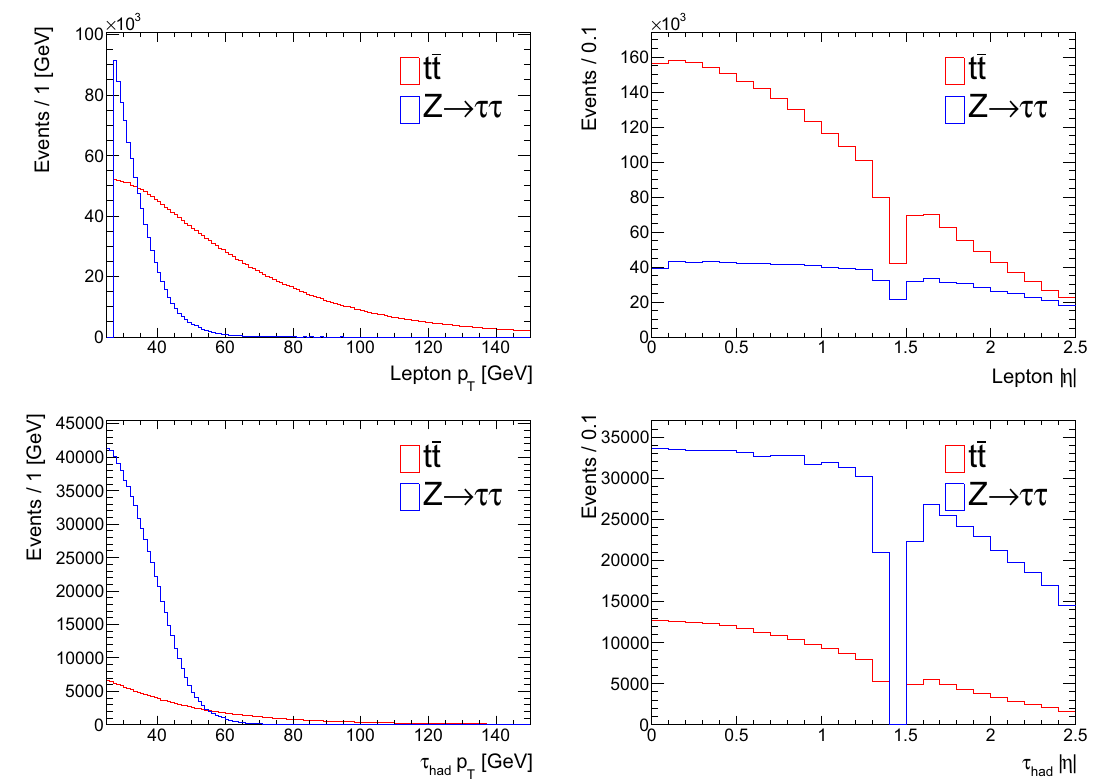
Fig. 6 The distributions of p T and | η | of e , μ , and τ had in the selected t ¯ t → b ¯ bW + W − and Z /γ ∗ → ττ candidate event samples. The left column shows p T and the right column shows | η | . The top row shows e and μ candidates. The bottom row shows τ had